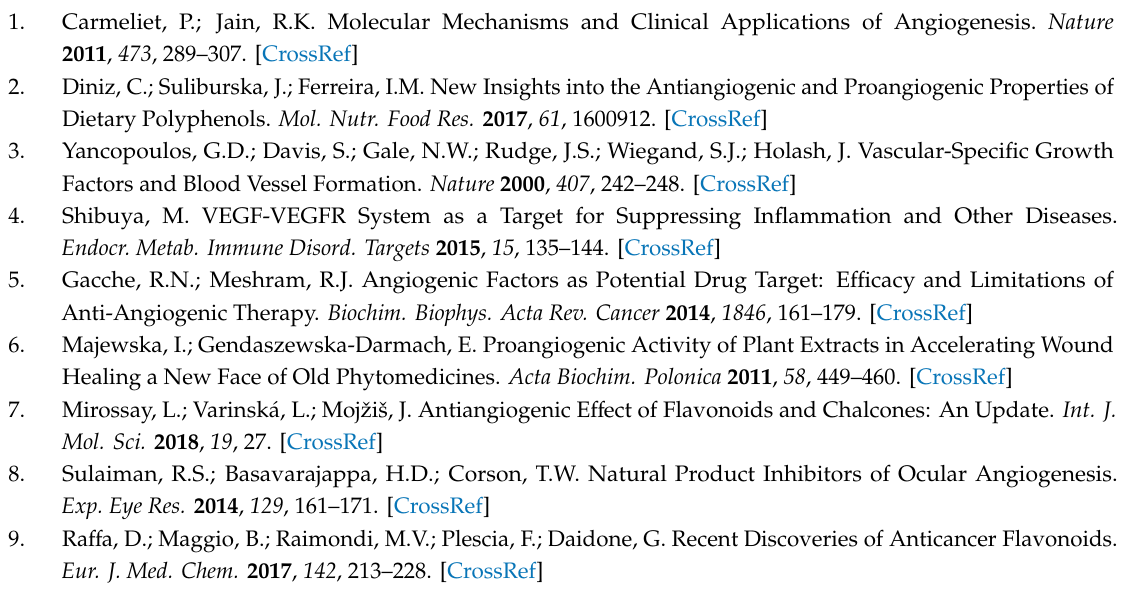
Supplementary Materials: The following are available online, Table S1: Study characteristics of Section 1, Tables S2–S4: Sensitivity analysis, Tables S5 and S6: Database search results, Table S7: PRISMA